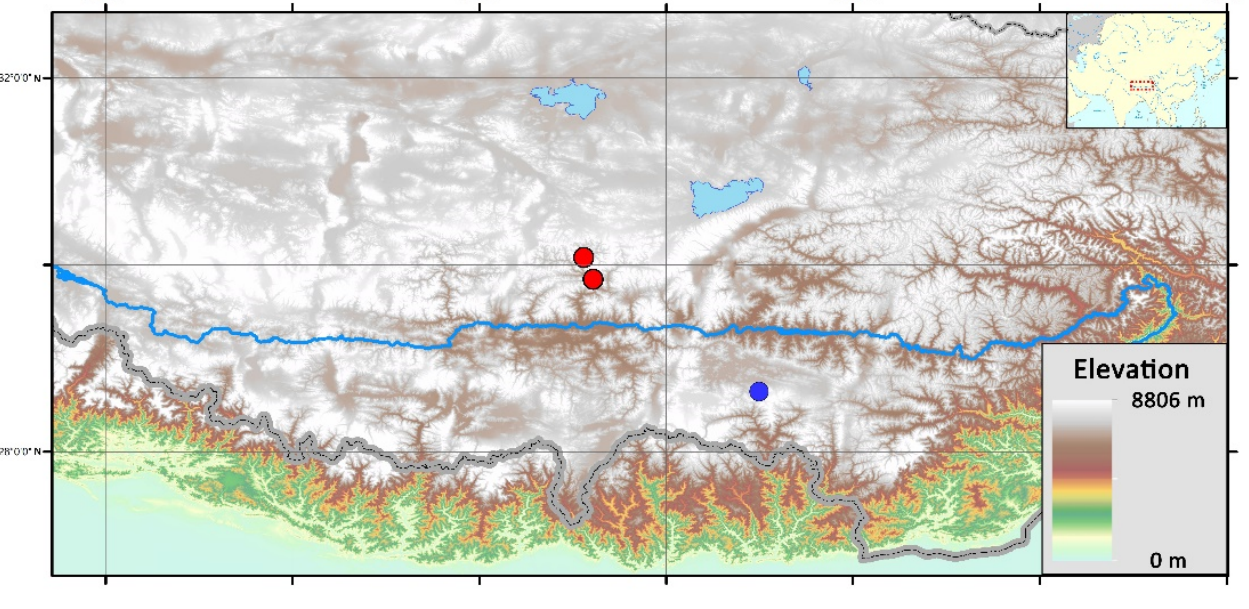
Figure 5. Rhodiola wangii S.Y. Meng. ( A ). Rhizome and flowering stem; ( B ). Female plants; ( C ). Male plants.